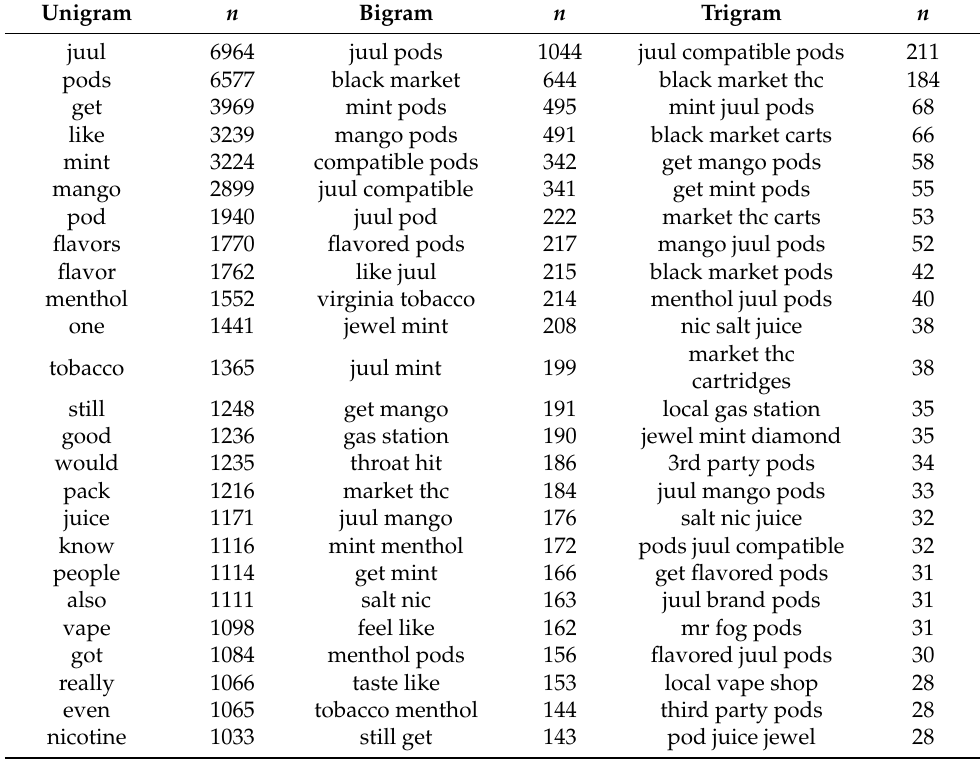
Table 1. Most frequently used terms (n-grams) related to flavored electronic cigarette policy restric- tions